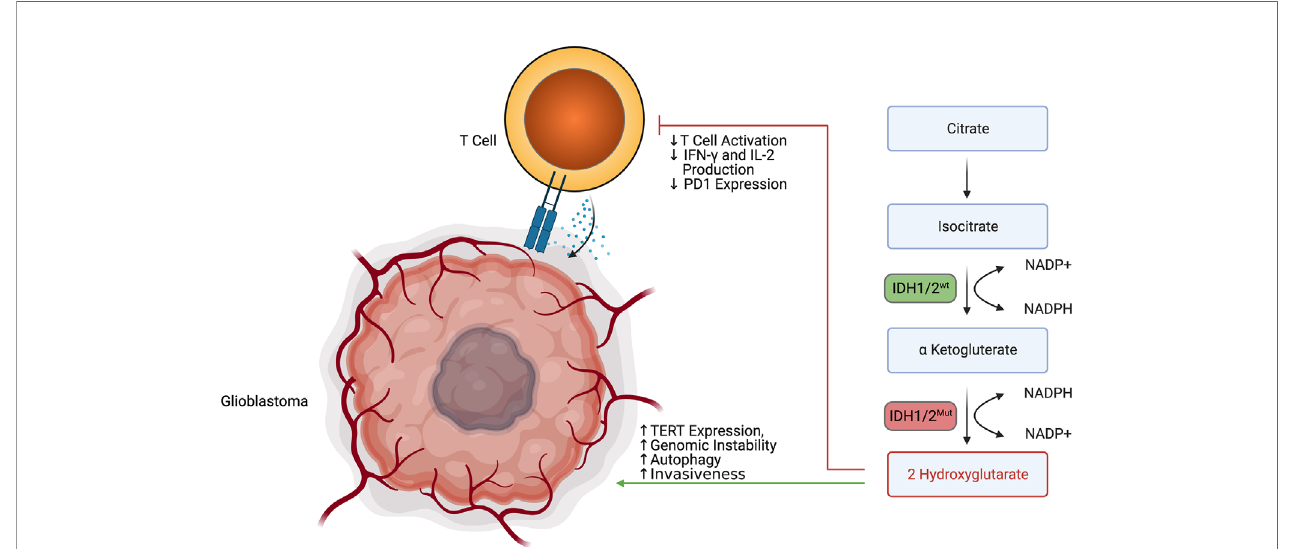
FIGURE 6 | Glioblastoma cells control the amount of extracellular adenosine in the glioblastoma immune microenvironment and use adenosine to decrease T cell degranulation and increase T cell